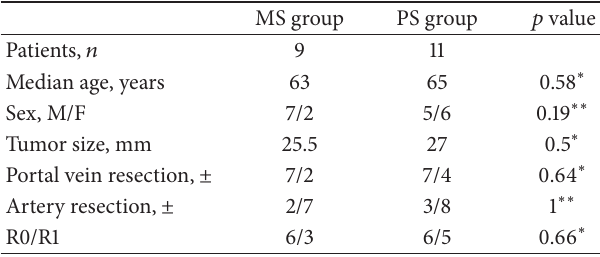
Table 1: Patients’ baseline clinical